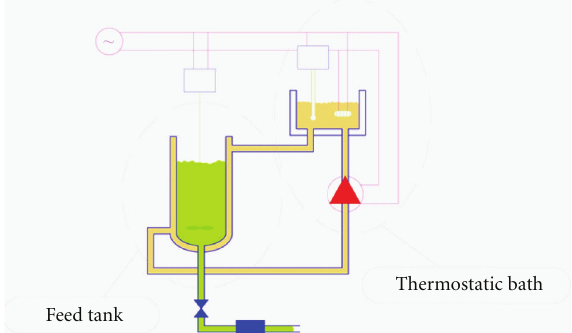
Figure 5: Feed tank for the mixtures of pork fat and diesel.